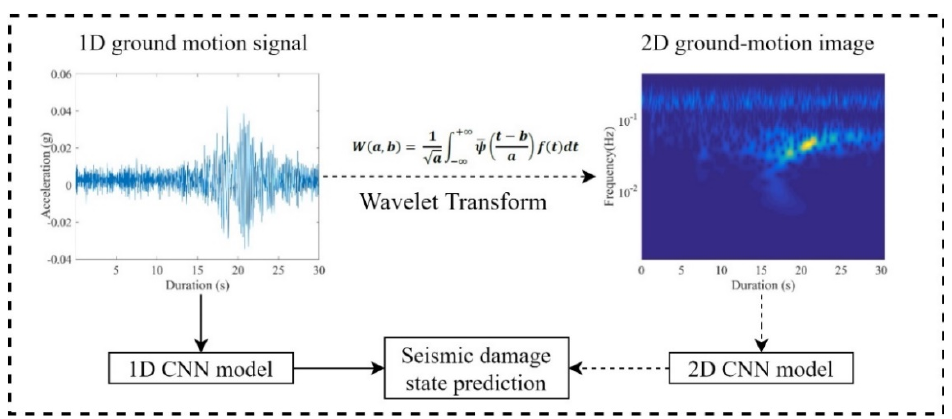
Figure 1. The pipelines of seismic damage state prediction with 1D CNN (solid arrows) only and 2D CNN (dash arrows) that requires image encoding of the GMR images. CNN (dash arrows) that requires image encoding of the GMR